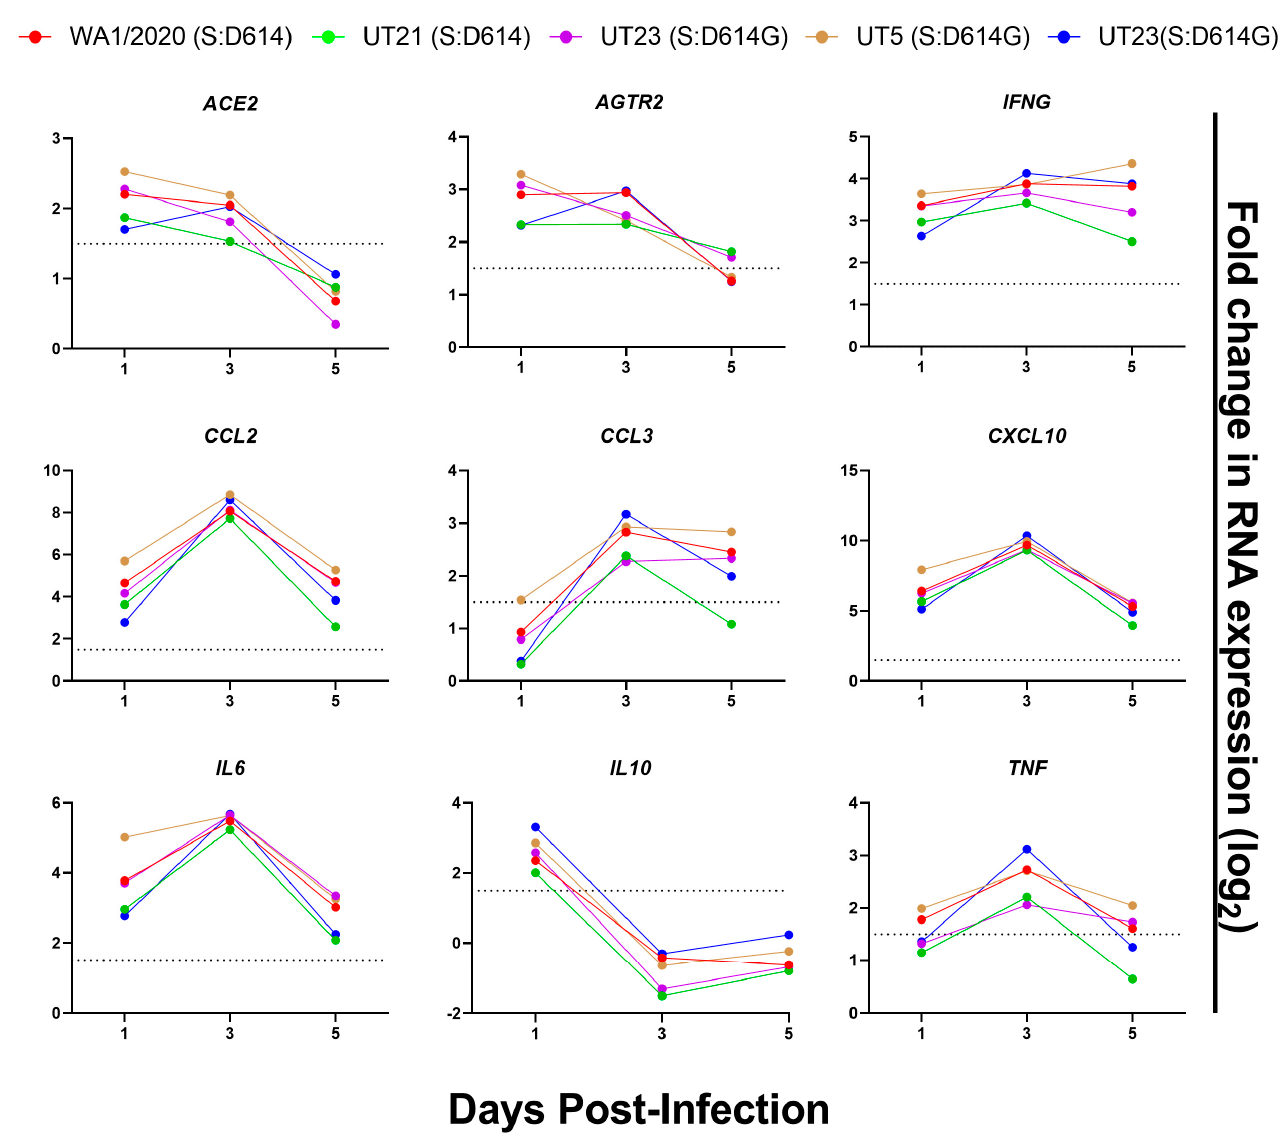
Figure 9. Selected gene expression profiles of lungs from K18-hACE2 inoculated with mock or SARS-CoV-2 variants. RNA was isolated from lungs ( n = 4) harvested from mice on 1, 3, and 5 dpi and analyzed with a QuantiGene Plex panel targeting 50 genes (Table S7). V = To calculate gene expression, the measured average background fluorescent intensity of each measured gene was subtracted from mean fluorescent intensity of each gene in each sample. These values were normalized to that of an endogenous control within each sample. Normalized expression values were used to calculate log2 fold change as compared to that of mock-infected mice. Data are shown from WA1/2020 (red), UT21 (green), UT29 (violet), UT5 (brown), and UT23 (navy blue). The dotted line in each graph represents log2 fold change =